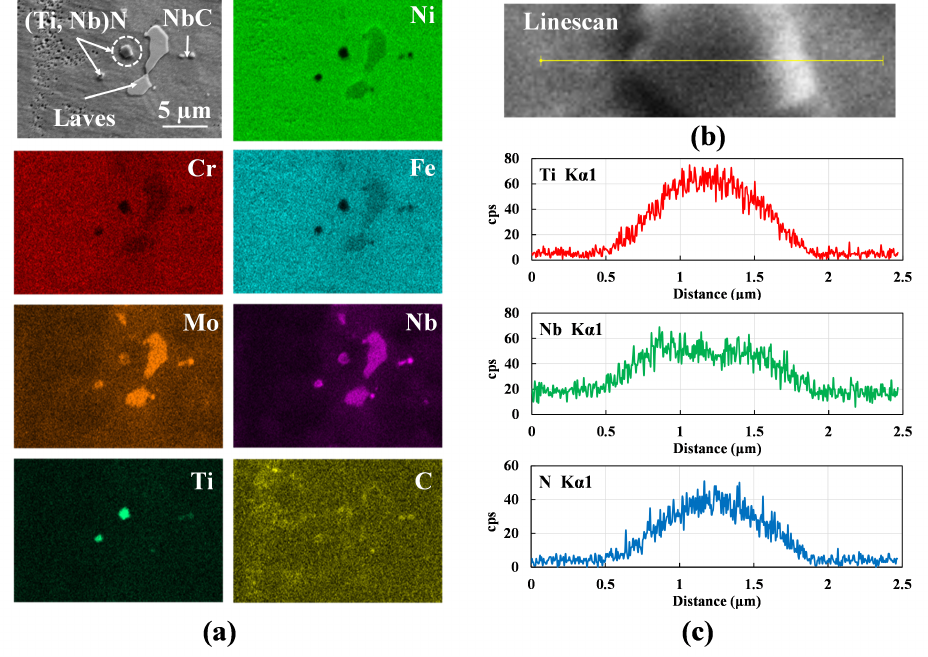
Figure 15. ( a ) EDS map of a representative region within the wire-fed specimen where TiN and NbC precipitates are seen and circled. ( b ) zoomed image of the marked region across which EDS line scan is obtained. ( c ) EDS line profiles of Ti, Nb, and N across the circled precipitate in ( a ) which is zoomed in ( b